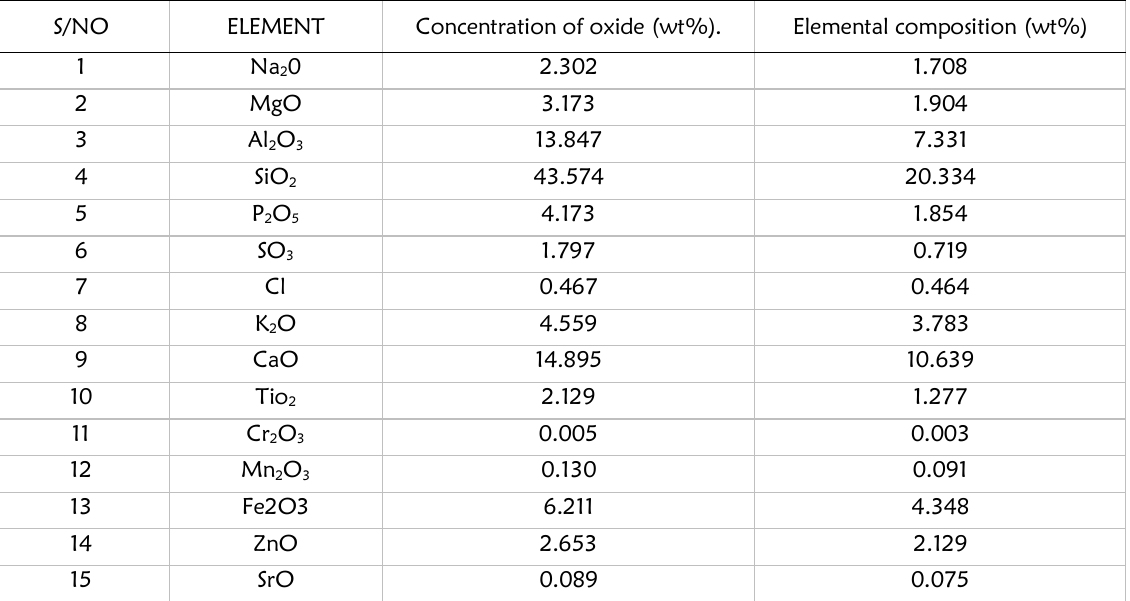
Table 5: Elemental Composition of MSSA using (XRF)